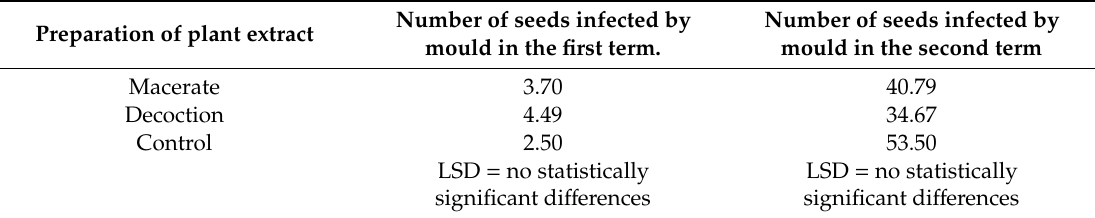
Table 2. Influence of the method of obtaining plant extracts on limiting the development of moulds-average number of contaminated seeds (%). Preparation of plant extract mould in the first